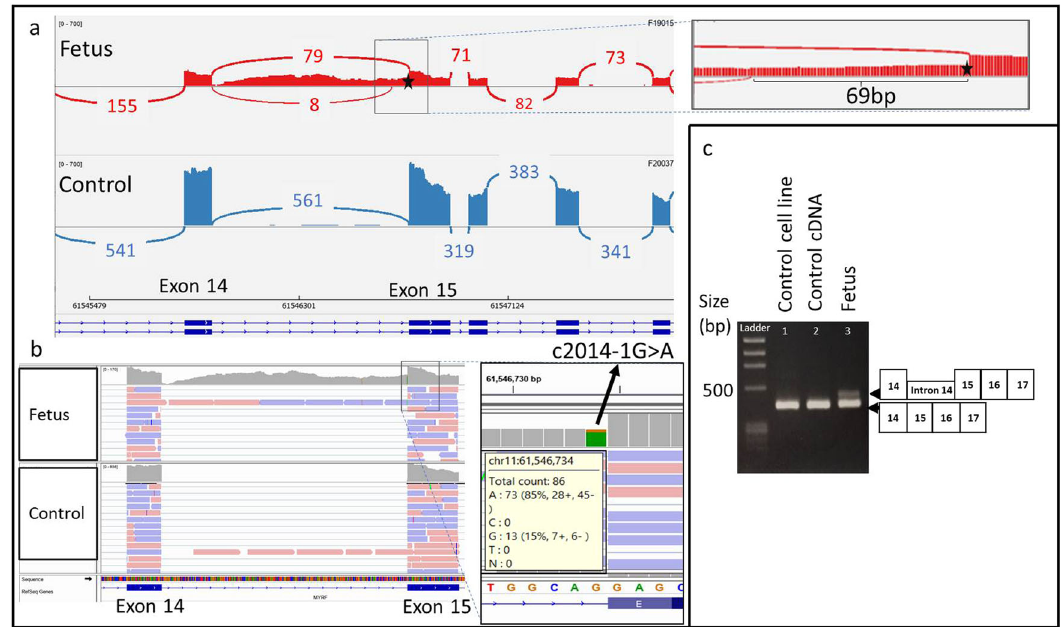
Fig. 4 Family 2 with the MYRF splicing variant. a Sashimi plot, and b IGV pro fi le showing an in frame 69-bp intron 14 retention, and a complete intron 14 retention, activated by NM_001127392.1:c.2014-1 G > A. This was not observed in another AF cell control. The splicing variant was also absent in gnomADv2.1.1. The location of the variant has been indicated with a star. c RT-PCR with primer pairs spanning exons 14 to 17 with an expected size of 364 bp for the wildtype and 433 bp for the transcript with partial intron retention. The squared boxes on the right indicate the exon